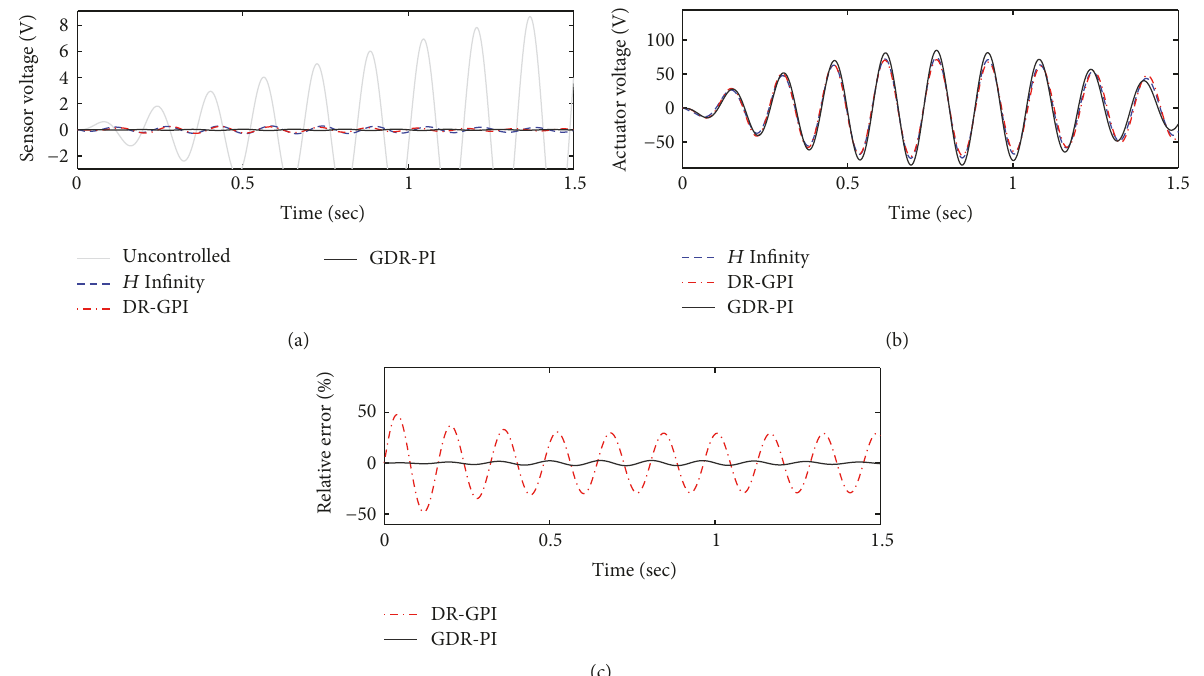
Figure 5: The time domain response of the controlled and uncontrolled smart beam under a harmonic disturbance with unknown influence matrix and the first eigenfrequency: (a) sensor output, (b) control input, and (c) relative error of estimated disturbance.